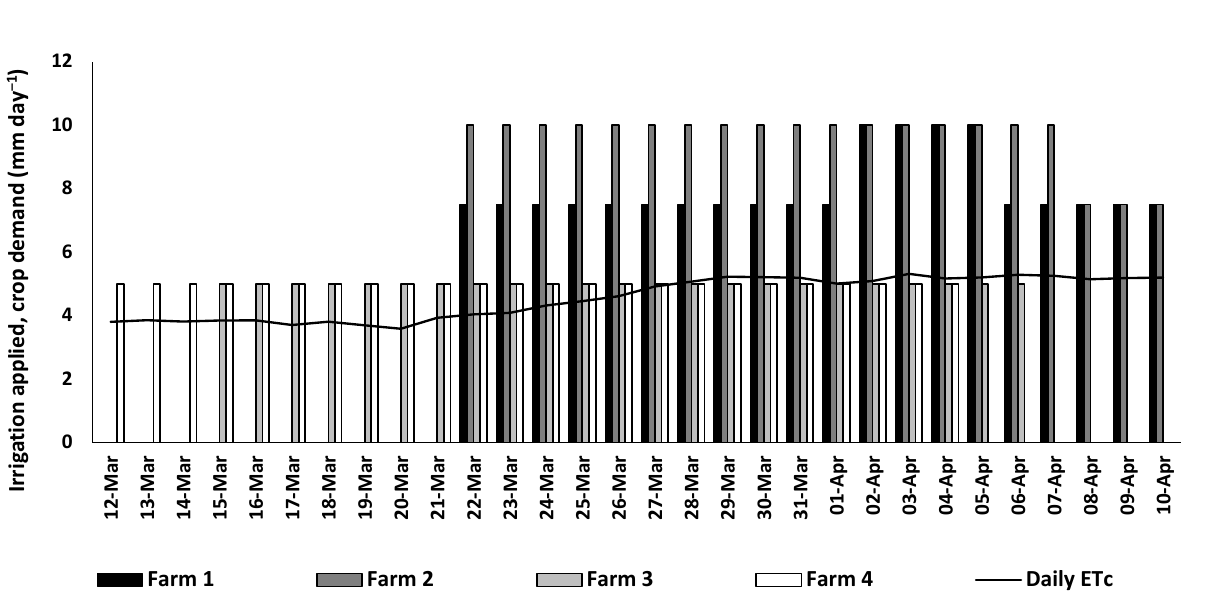
Figure 2. Daily application measured on four farms in Chhouk, Kampot Province, Cambodia, showing differences in the depth of water applied to similar crops in similar growing conditions, and compared to predicted ET c.